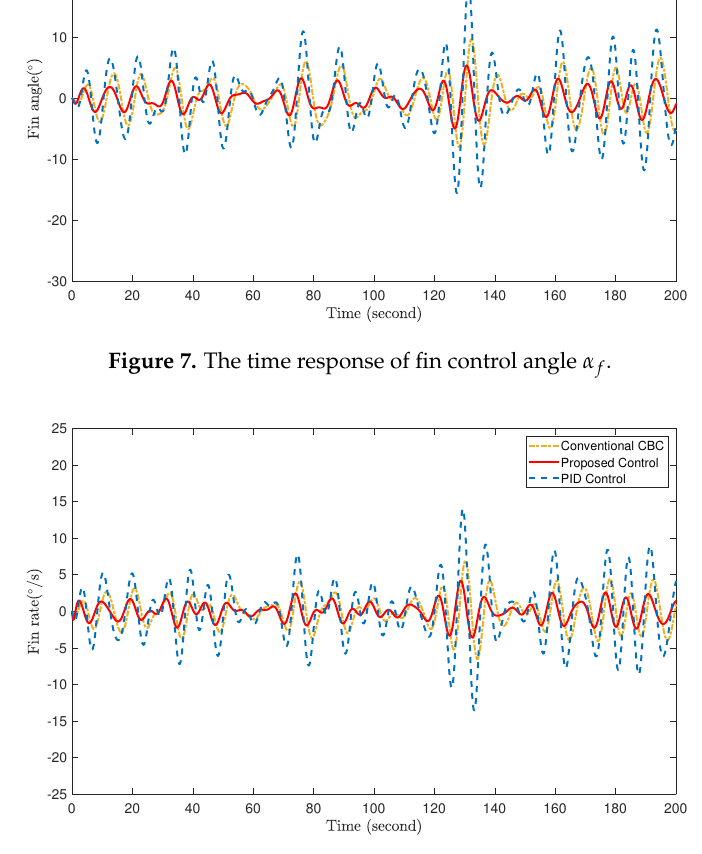
Figure 8. The time response of fin